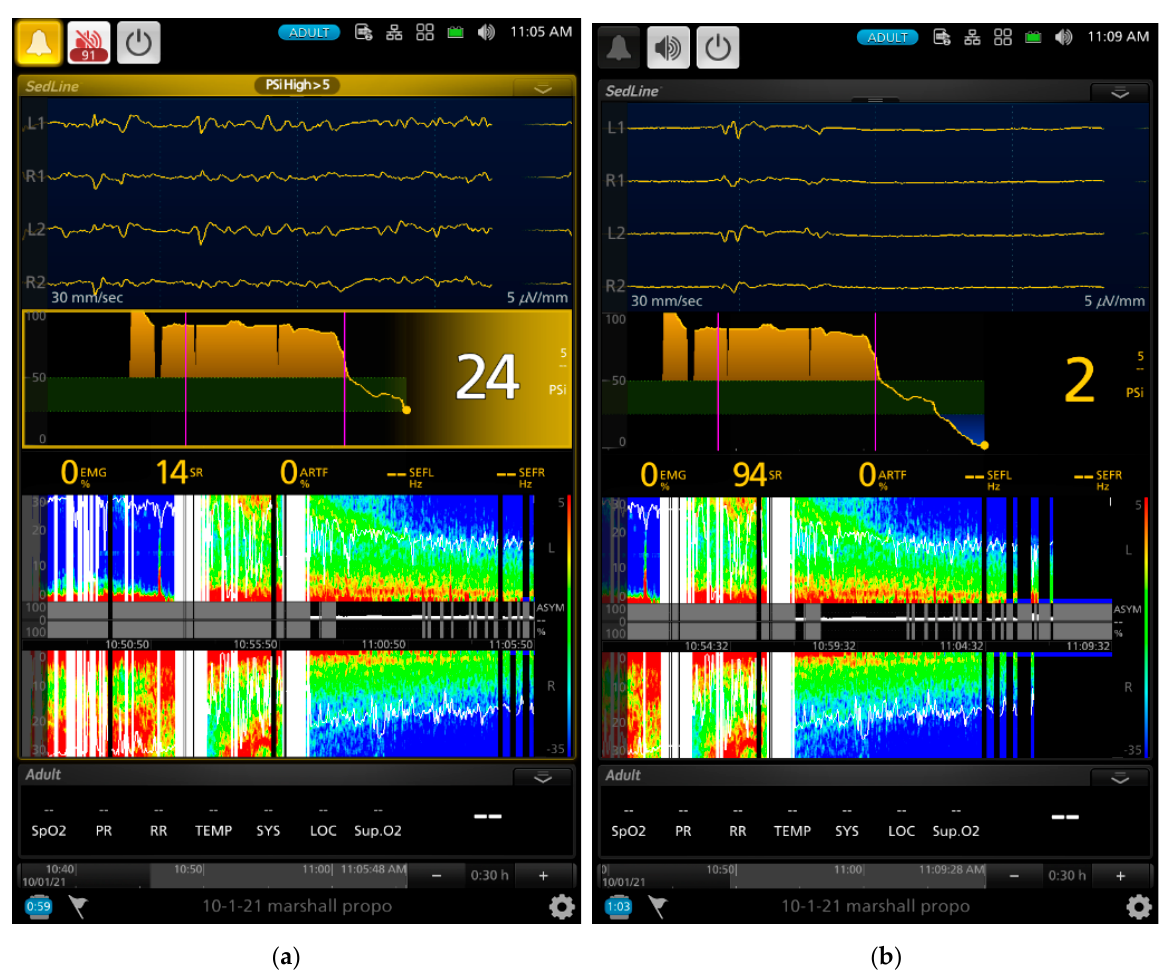
Figure 3. Screenshots of the same dog as presented in Figure 1 in different phases of propofol anesthesia. ( a ) shows a transition of the dog reaching a stable anesthetic plane soon after endotracheal intubation and progressing to a deeper plane of anesthesia. In the figures, the first pink vertical line represents the beginning of the propofol gradual induction, and the second vertical pink line represents the completion of the graduate induction and the beginning of the 2.4 mg/kg/min propofol CRI. The EEG pattern shifted from delta–theta and alpha slow oscillation patterns in ( a ) to prolonged isoelectric flat line EEG wave with burst suppression in ( b ). The spectral pattern of burst suppression appeared on the right side of the DSA as multiple black vertical bars with blue tips in both ( a , b ). As the propofol CRI continued, the burst suppression started to become more dominant (from 14% in ( a ) to 94% in ( b )), and the disappearance of other spectral patterns was due to the prolonged isoelectric EEG pattern. The PSI values fell from the early propofol induction phase of 80 (Figure 2b) to 24 ( a ) and reached a profoundly deep plane of anesthesia with a PSI value of 2 ( a ).